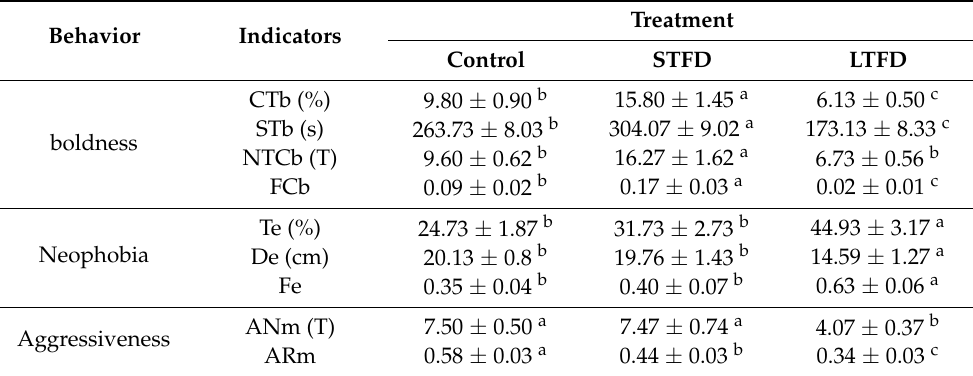
ANm (T) 7.50 ± 0.50 a Aggressiveness ARm 0.44 ± 0.03 b 0.34 ± 0.03